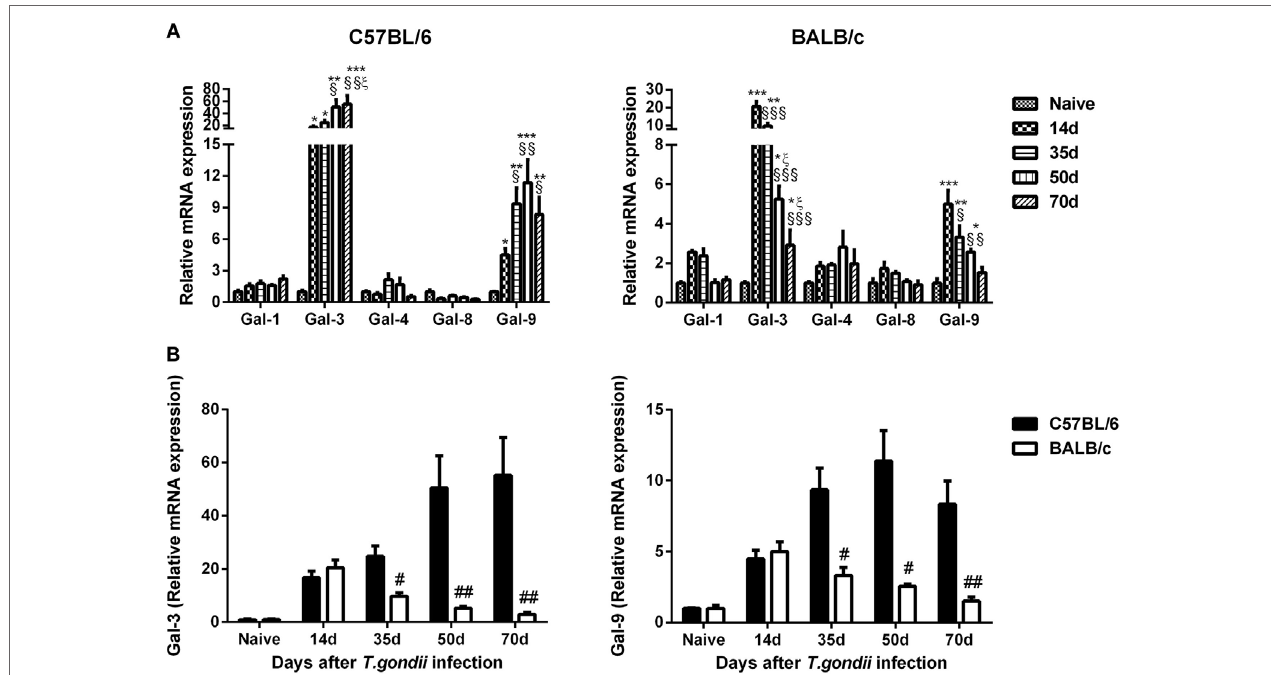
FigUre 5 | Relative mRNA expressions of Gal-1, Gal-3, Gal-4, Gal-8, and Gal-9 in the brain tissues of Toxoplasma gondii Pru strain-infected C57BL/6 and BALB/c mice were detected by using quantitative real-time reverse transcription-polymerase chain reaction. (a) Galectin expressions in the brains of C57BL/6 and BALB/c mice. (B) Comparison of Gal-3 and Gal-9 levels in the brains of C57BL/6 and BALB/c mice. Values are means from triplicate measurements, and data are presented as mean ± SD. There were four mice per group. The data shown are representative of those from two different experiments. * P < 0.05, ** P < 0.01, and *** P < 0.001 vs naive; § P < 0.05, §§ P < 0.01, and §§§ P < 0.001 vs 14 days post infection (p.i.); ξ P < 0.05 vs 35 days p.i.; # P < 0.05 and ## P < 0.01 vs C57BL/6 mice.